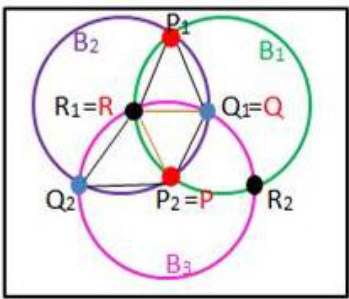
Figure 4. Calculate the Vertices in a